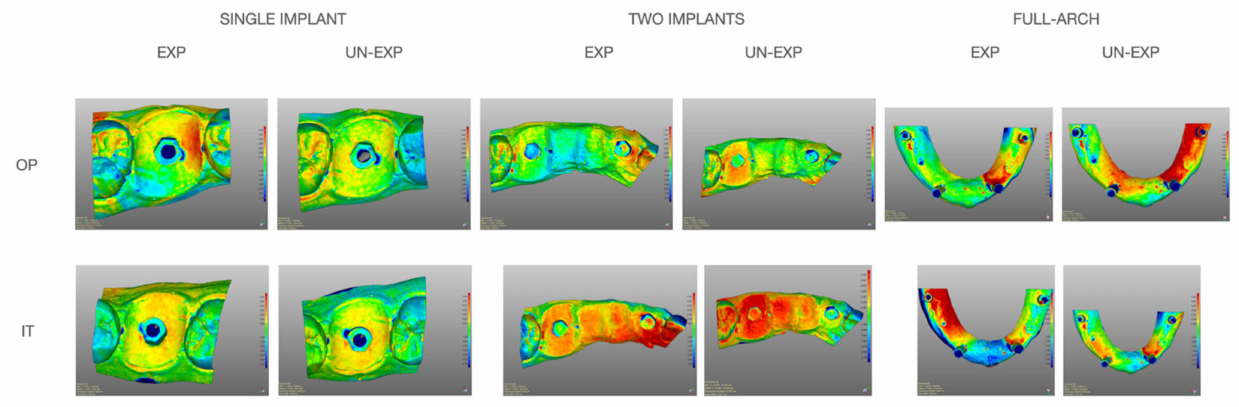
Figure 2. Evaluation of average deviation between RD (reference dataset) and DI (digital impression). Distances were color-coded using the 3D deviation function. IT (Itero IOS); OP (Opera system); EXP (expert operator) UN-EXP (un- experienced